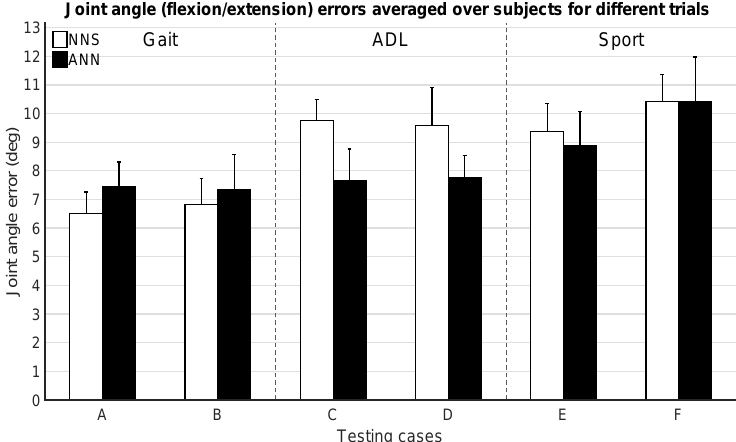
Figure 8. Mean (over all six subjects) and standard deviation (between the six subjects) of joint angle (flexion/extension) errors for different testing cases, as described in Table